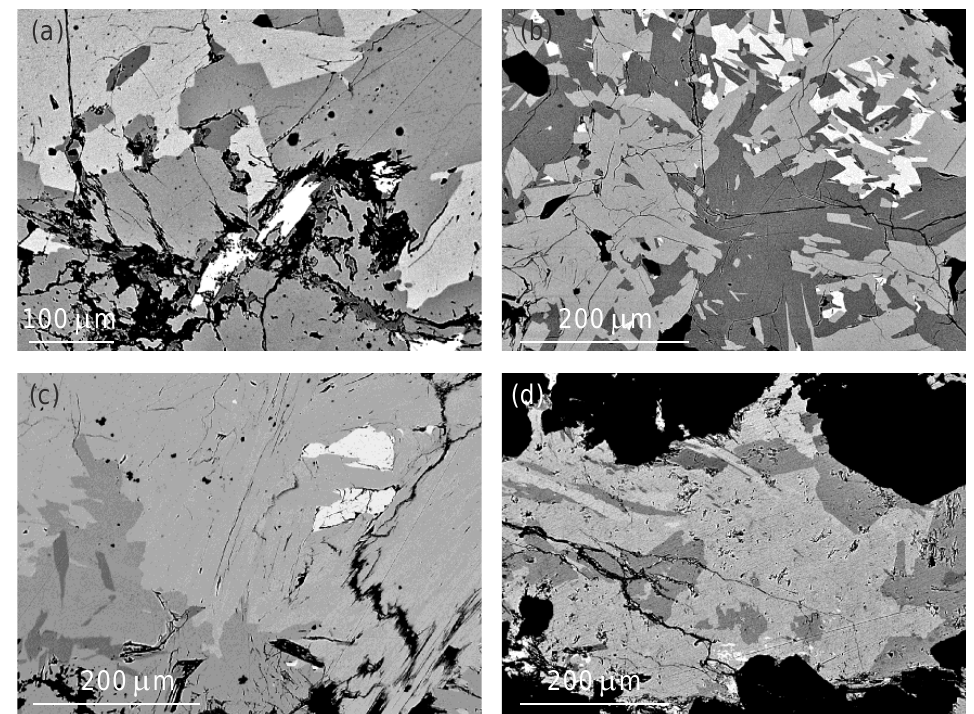
Figure 4. ( a ) The elongated euhedral to subhedral grains of semseyite (white) in fissures of zinkenite aggregates (dark); in association with robinsonite (lighter grey) and jamesonite (darker grey); ( b ) dadsonite metacrysts (grey) replaced earlier boulangerite (white) and robinsonite (dark); ( c ) rouxelite aggregates (light grey) with relics of boulangerite (white) replaced earlier robinsonite (dark grey) with jamesonite metacrysts (dark); ( d ) disulfodadsonite aggregates (grey) in association with earlier robinsonite (dark grey), chovanite (lighter grey), and with relics of boulangerite (white). BSE photos.